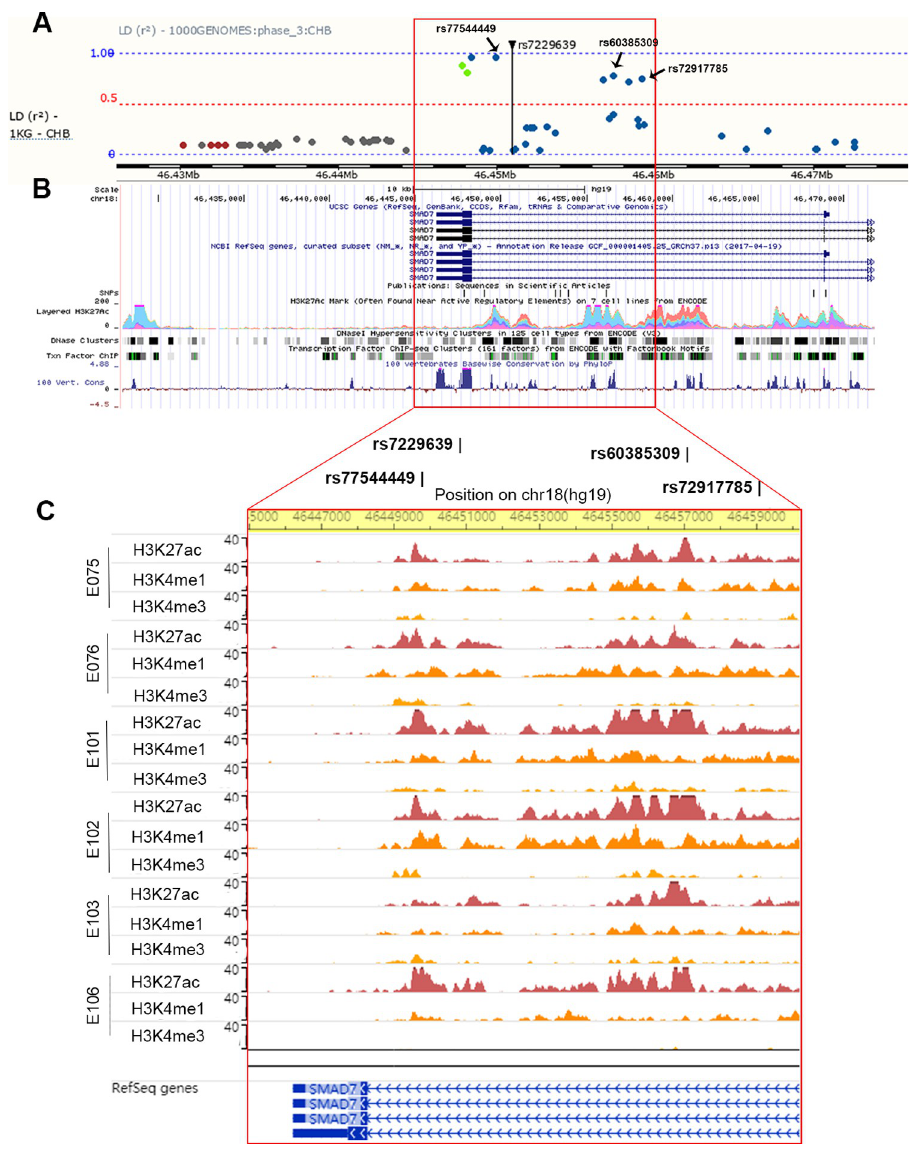
Fig 2. Overview of the genomic and epigenetic profiling in the LD region of rs7229639. ( A ) LD Manhattan plot of rs7229639 in CHB population (1000 Genomes phase 3) showed eight additional variants in high LD with rs7229639 ( r 2 > 0.5), including rs77544449, rs60385309, and rs72917785. The data were obtained from the Ensembl Genome Browser (v96). ( B ) Epigenetic annotation for LD region of rs7229639, including active histone modification H3K27ac, DNase I hypersensitivity and TF binding sites. These data were obtained from the ENCODE Project database and visualized by UCSC genome browser. ( C ) Tissue-specific histone modification signals (H3K27ac, H3K4me1 and H3K4me3) of the LD region of rs7229639 in six tissues, including Colonic Mucosa (E075), Colon Smooth Muscle (E076), Rectal Mucosa Donor 29 (E101), Rectal Mucosa Donor 31 (E102), Rectal Smooth Muscle (E103), and Sigmoid Colon (E106). The data were taken from the Roadmap Epigenomics Project and visualized by the WashU Epigenome Browser. respectively), with the major alleles responsible for the enhancer activity, an effect opposite to the eQTL results of the LIPG gene (S2 Fig). The impact on the luciferase expression was dis- tinctively strengthened when two SNPs within the same PRE were both mutated (Fig 3A and 3B). Consistent results were also obtained in two CRC cell lines (Fig 3C–3F). Together, these